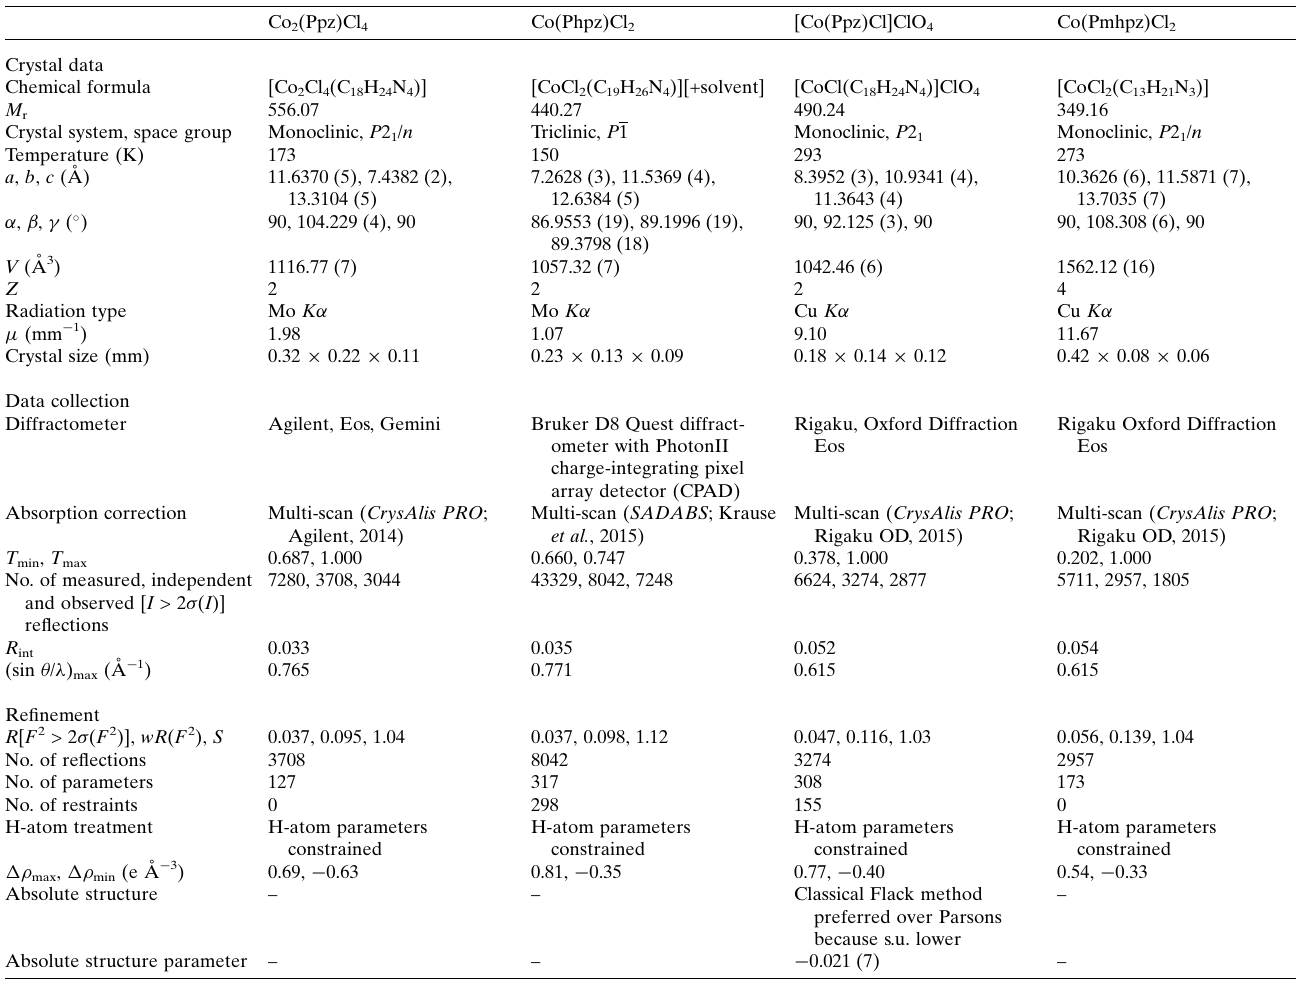
Table 7 Experimental